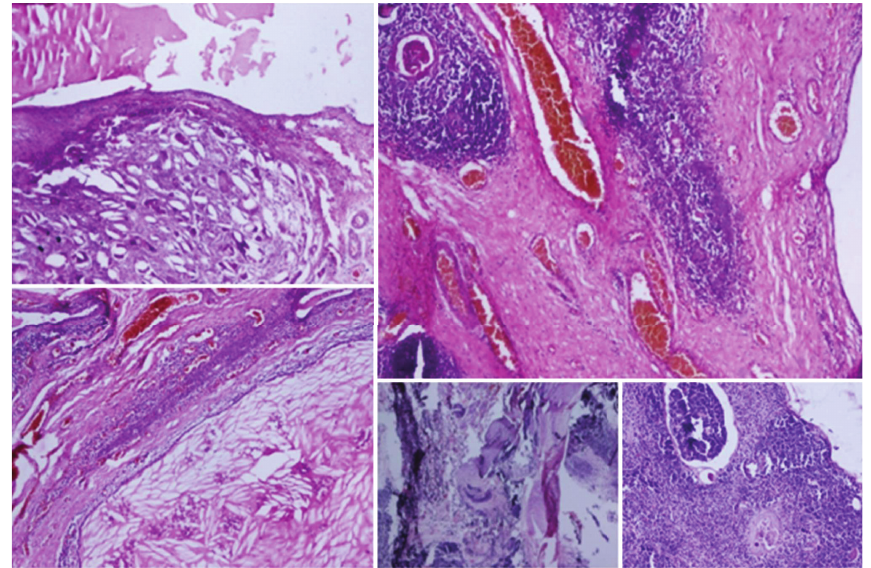
Figure 3: Histopathological examination revealed multiple cystic spaces lined by cuboidal to squamous epithelium. The cyst contained numerous cholesterol clefts with subepithelium showing fibrocartilagenous tissue, foreign body corpuscles, and Hassall’s corpuscles.